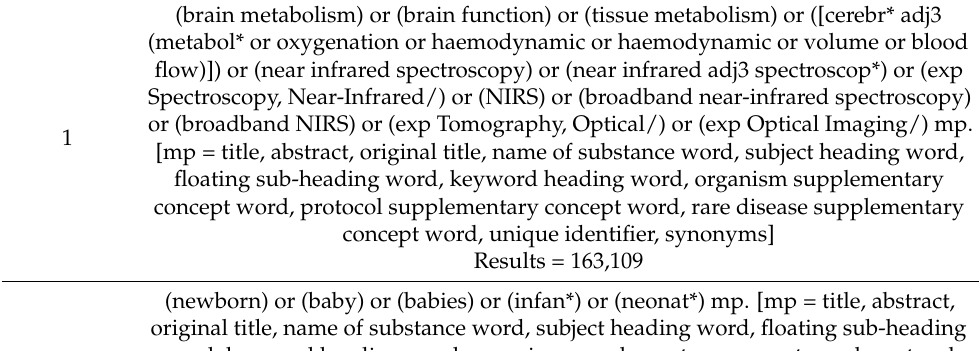
Table 1. Search strategy used for Medline (Ovid version) search. (brain metabolism) or (brain function) or (tissue metabolism) or ([cerebr* adj3 (metabol* or oxygenation or haemodynamic or haemodynamic or volume or blood flow)]) or (near infrared spectroscopy) or (near infrared adj3 spectroscop*) or (exp Spectroscopy, Near-Infrared/) or (NIRS) or (broadband near-infrared